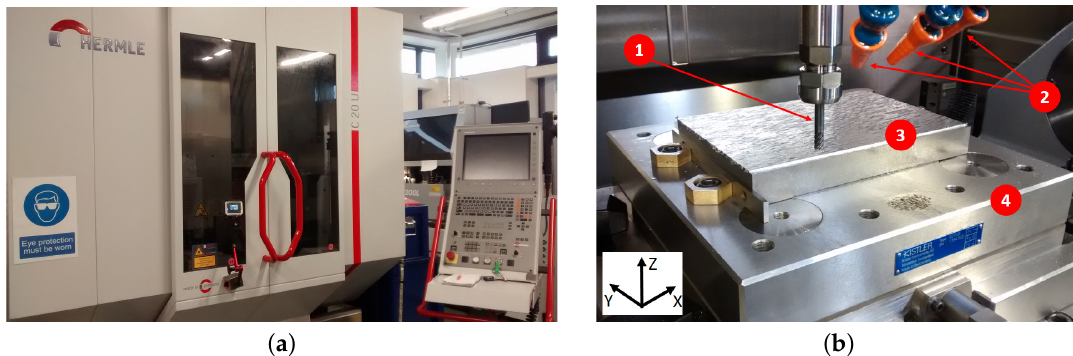
Figure 2. ( a ) The Hermle C20U CNC machine together with its Heidenhain iTNC 530 control. ( b ) Interior of the CNC machine equipped with a tool (1), compressed air nozzles (2), a workpiece (3) and a three-component force sensor dynamometer Kistler